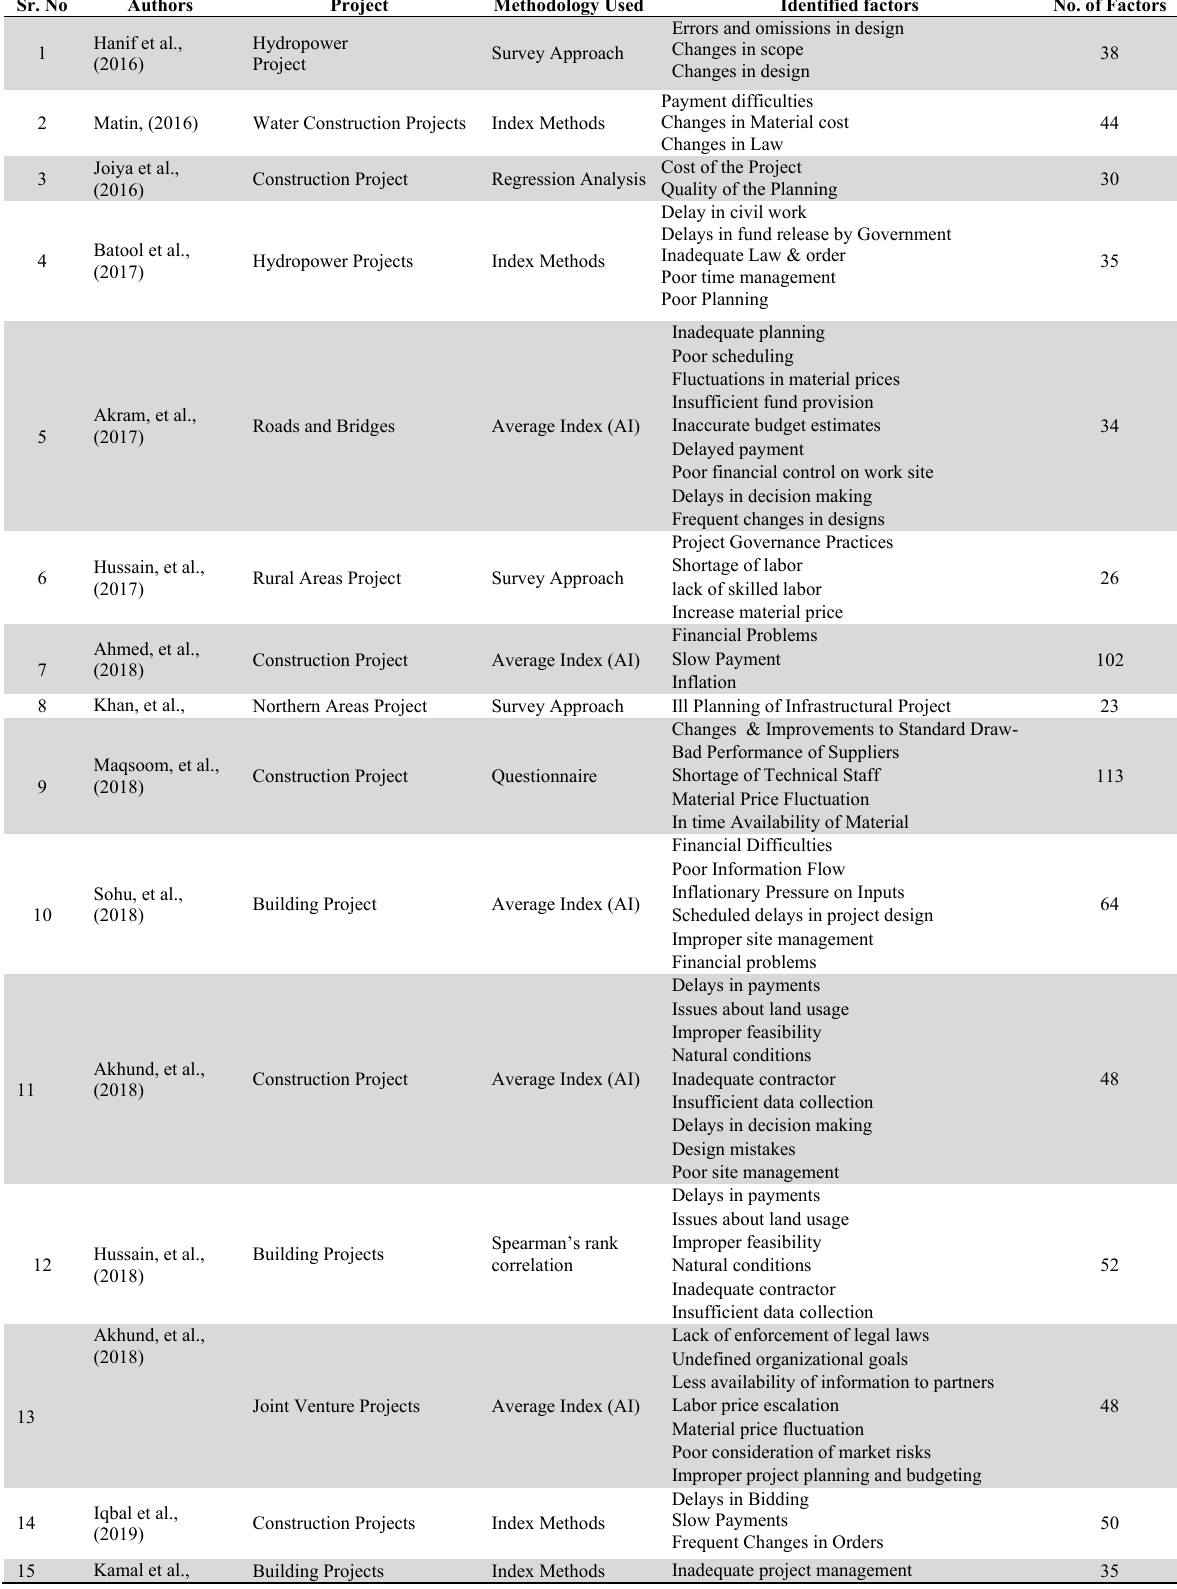
Table 1 Existing Literature of Identified Factors Related to Cost and Time Delays in Construction Projects Sr.